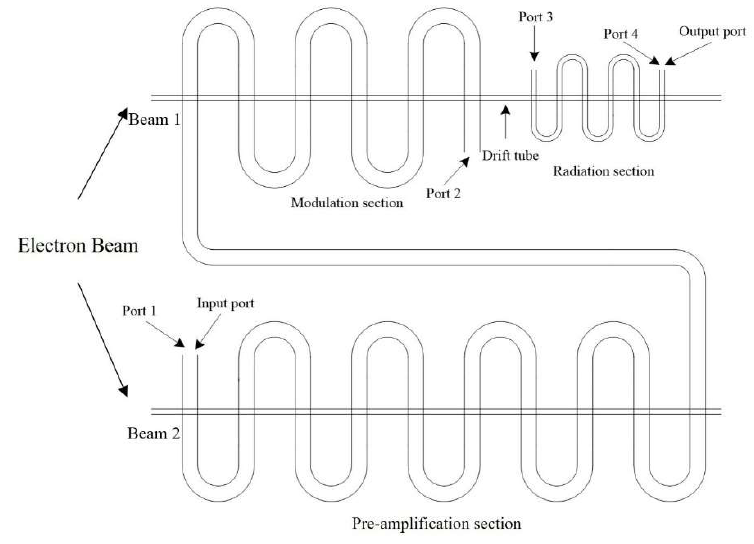
Figure 17. The SWS of dual beam PA-HHTWT.